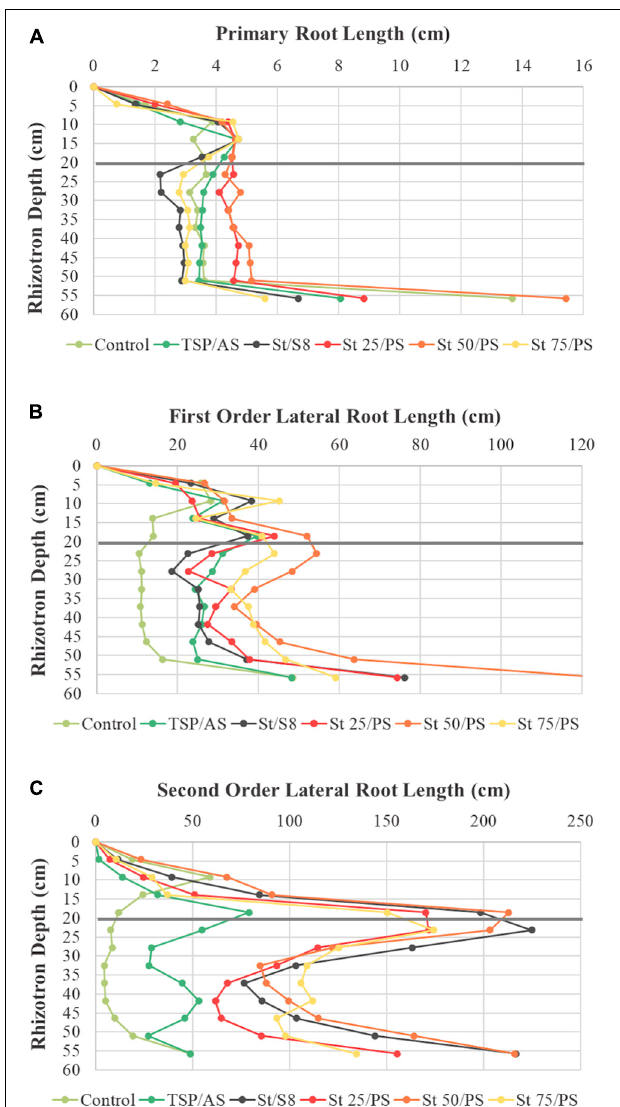
FIGURE 6 | Effect of treatments on different root types: (A) primary roots and (B) first and (C) second order lateral roots. Trends of root length density over the rhizotron depth are shown at harvest time point (40 days after sowing). The applied fertilizer layer is at a depth of 20 cm from top (marked with the gray line). Dots represent mean values.